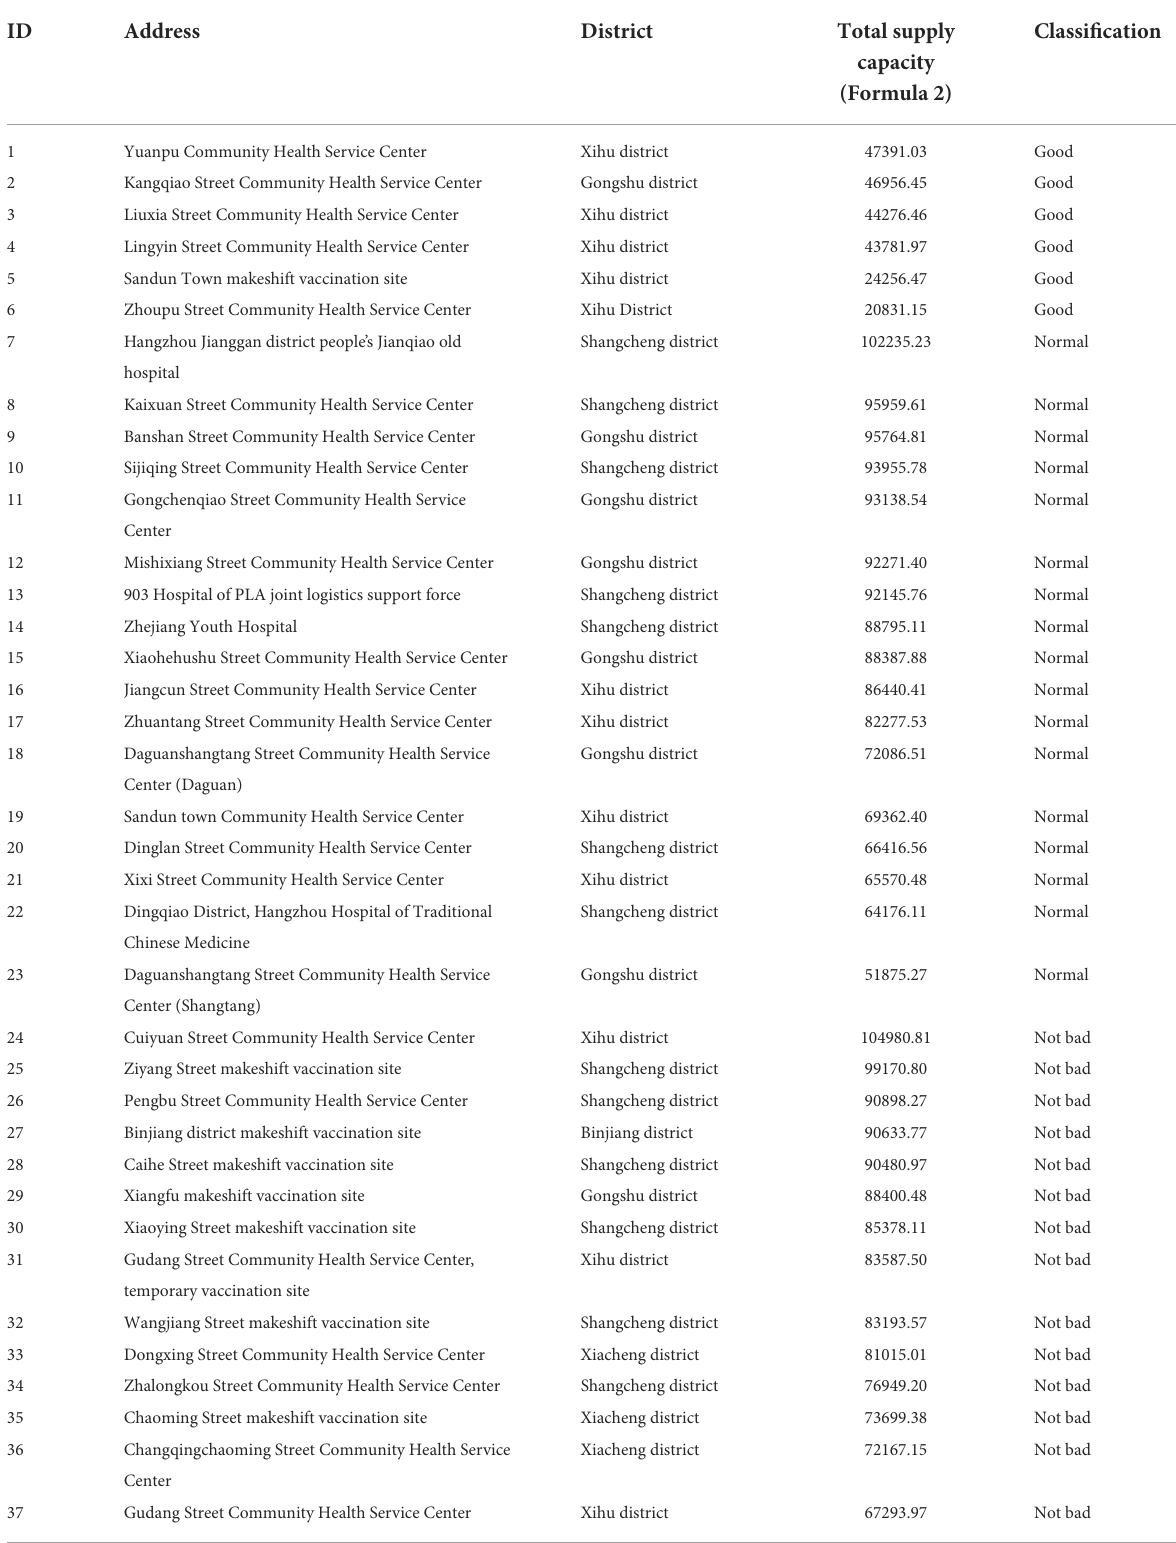
TABLE 1 Evaluation of medical supply capacity for 67 vaccination